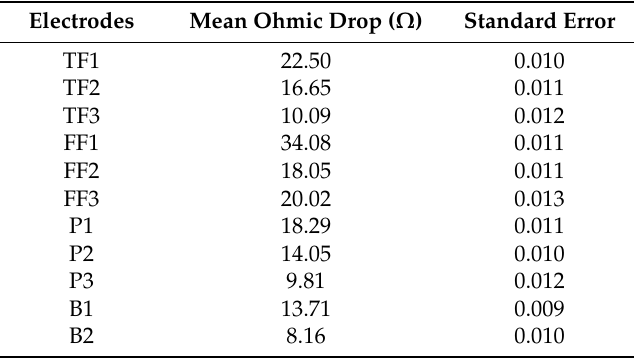
Table 2. Ohmic drop of each cell set-up. The standard error of the mean estimates the uncertainty associated to the determination of the ohmic drop.